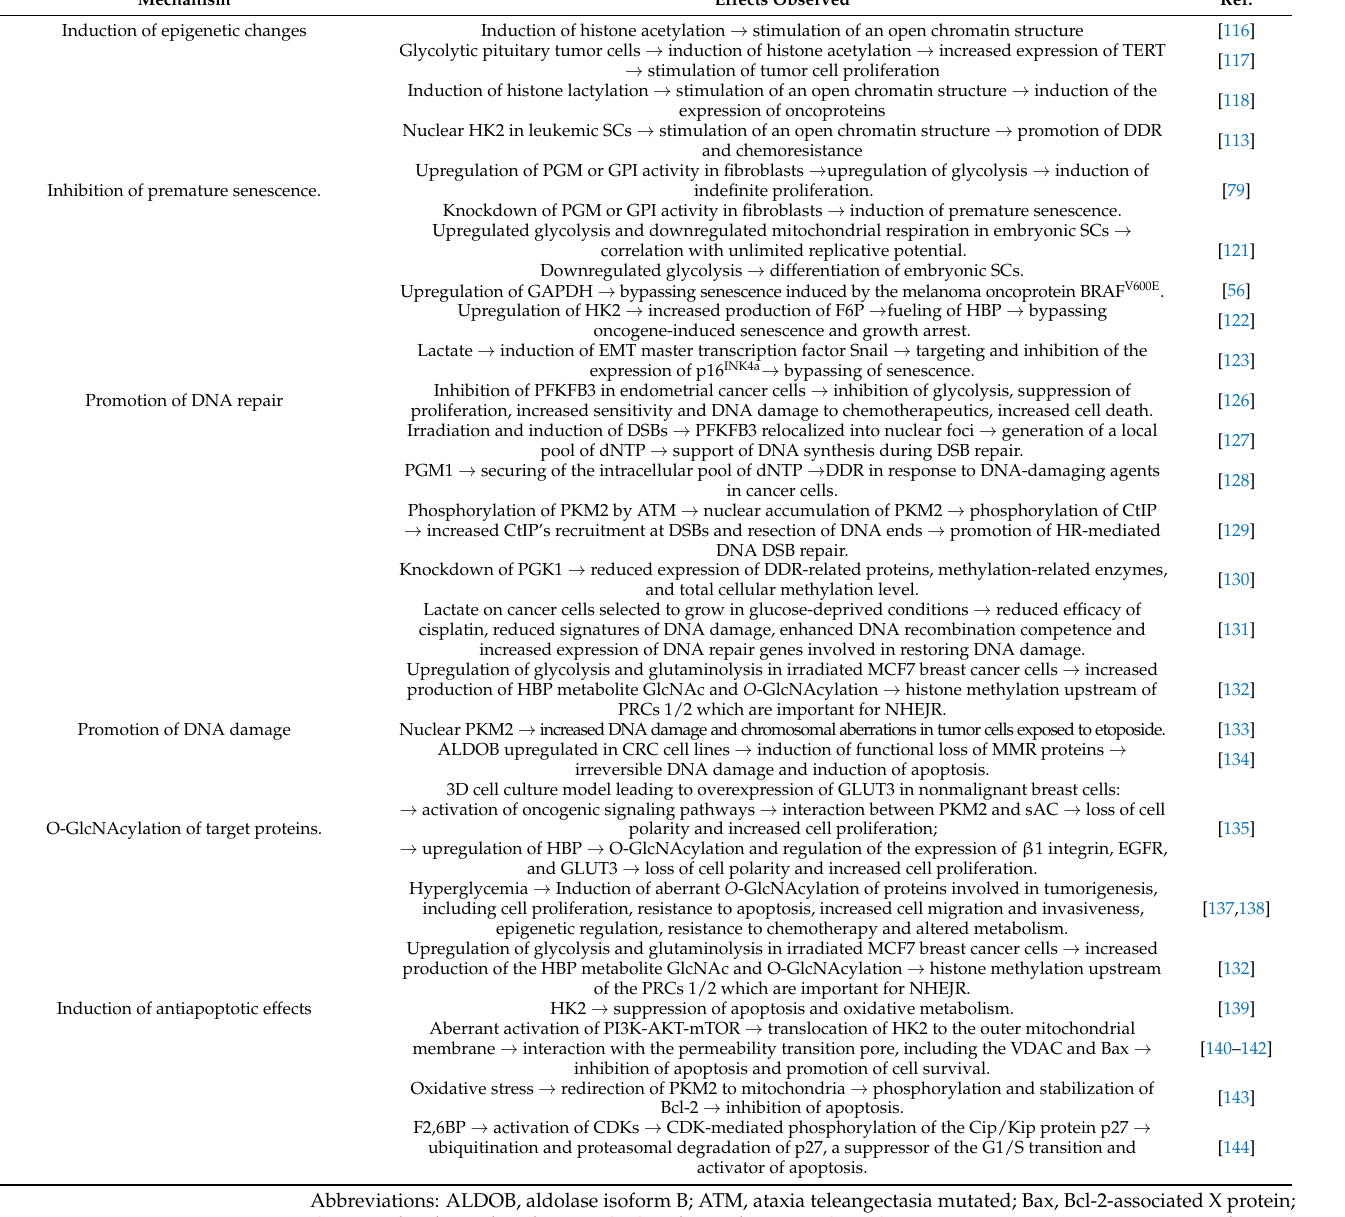
Table 2. Mechanisms underlying the effects of glycolysis in tumor initiation and early